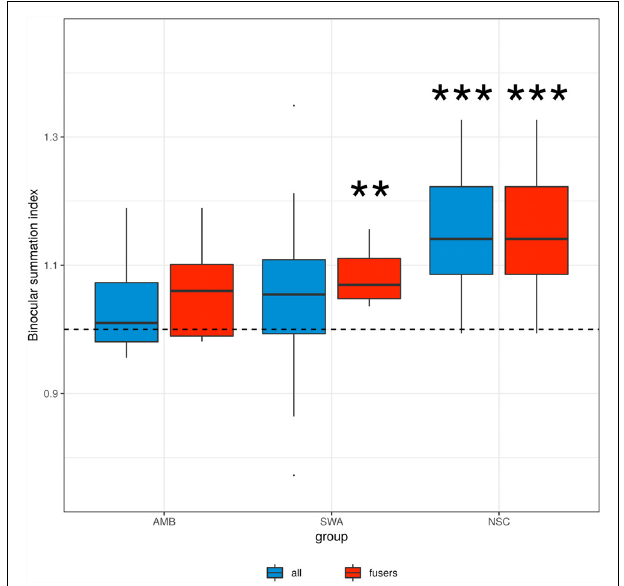
FIGURE 2 | Binocular summation index. Binocular summation was evaluated as the ratio of contrast sensitivity of binocular vision to that of the dominant eye (AULCSF Binocular /AULCSF DE ). Blue boxes indicate the data from all subjects in each group, red boxes indicate the data from the subset of amblyopic and strabismic subjects who are able to fuse at the testing distance. “ ∗∗ ” and “ ∗∗∗ ” denote statistical significance (two-sided t -test) at the alpha level of 0.01 and 0.001, respectively. SWA subjects who were able to fuse and NSC subjects showed an index significantly greater than 1, i.e., binocular